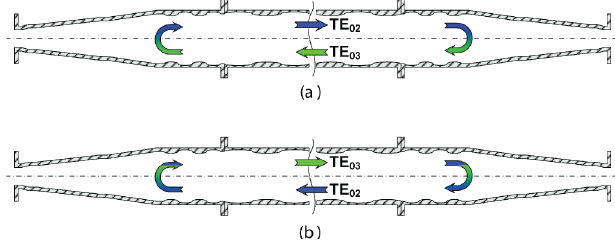
FIG. 2. (Color) One-channel SLED-II pulse compressor. 1, $ TE reflective mode converter; 2, TE TE 02 03 mission mode converter; 3, waveguide delay lines; 4, bellows.